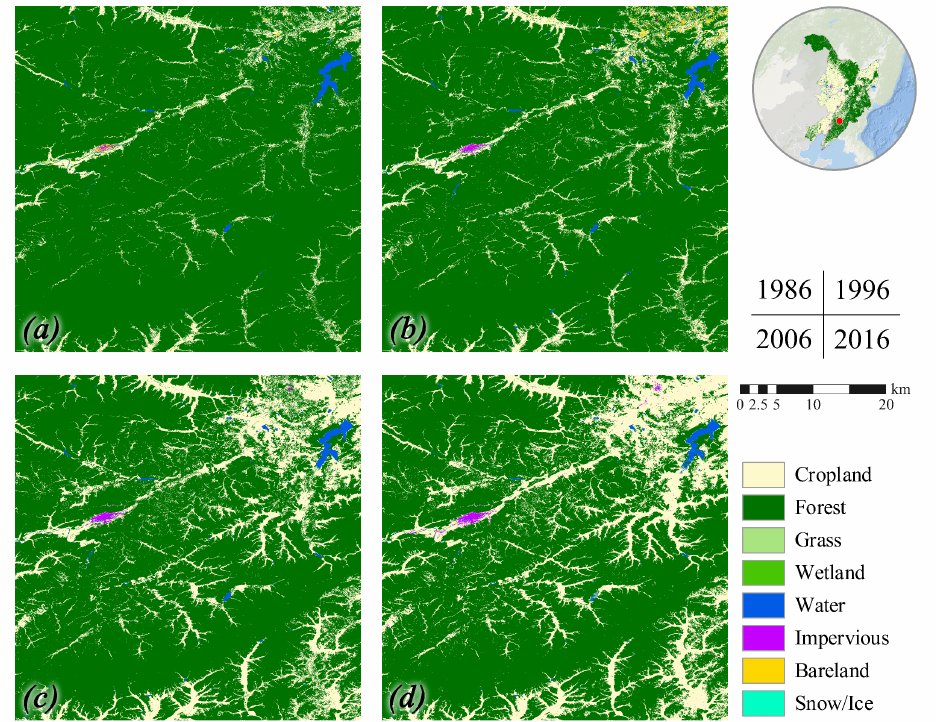
Figure 7. Forests loss caused by croplands expansion captured by the map series. The four subfigures show the land cover at the same place for year 1986 ( a ), 1996 ( b ), 2006 ( c ), 2016 ( d ). Note that forests in the valley were replaced by croplands